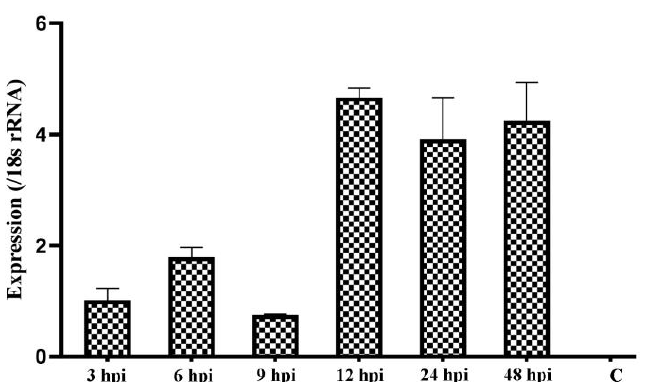
Figure 4. Relative expression of the Cpgp40/15 gene in HCT-8 cell culture of C. parvum after the normalization of Ct values of qPCR with data from the 18S rRNA gene of C. parvum . Data shown are mean ± SD from three replicate assays.